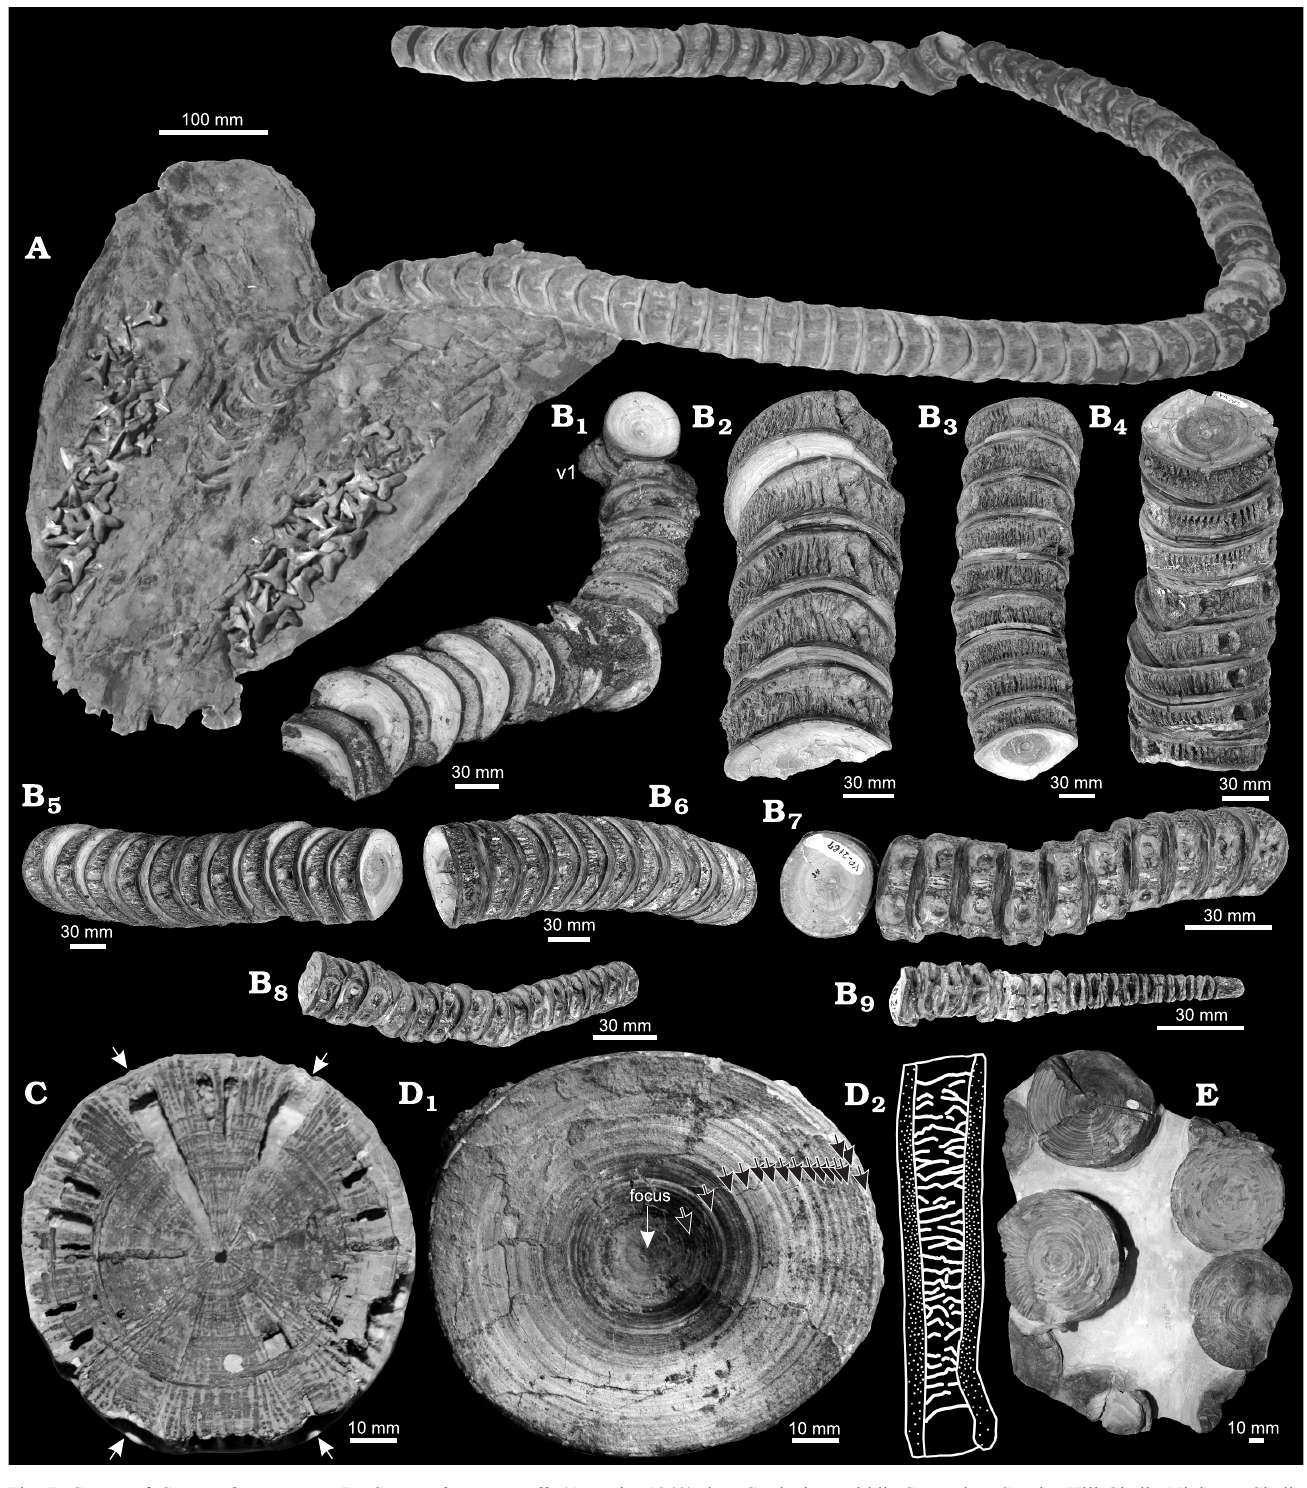
Fig. 7. Centra of Cretoxyrhina spp. A , B . Cretoxyrhina mantelli (Agassiz, 1843), late Coniacian–middle Santonian, Smoky Hill Chalk, Niobrara Chalk, Gove County, Kansas, USA. A . FHSM VP-323. B . FHSM VP-2187, articulated centra from various positions in the vertebral column; v1–14 (B occipital centrum, order corresponds to Fig. 6; v62–66 (B v209–227 (B ). C . Centrum in transverse section through about inner margin of the corpus calcareum of Cretoxyrhina mantelli , NHMUK OR.25939, 9 White Chalk Formation (?), near Sussex, UK; arrows indicate articular foramina for neural and ribs or haemal arches (see also Woodward 1912: pl. 43: 14). D . Centrum of Cretoxyrhina sp. (probably Cretoxyrhina agassizensis ), DMNH 746C, Eagle Ford Group, Cenomanian, Tarrent County, Texas, USA; view of face (D ) showing focus and 15 bands (black arrows) after the birth ring; tracing of left lateral view of centrum (D 1 Cretoxyrhina agassizensis ), NHMUK OR.49015, Cenomanian–Turonian, near Kent (?),